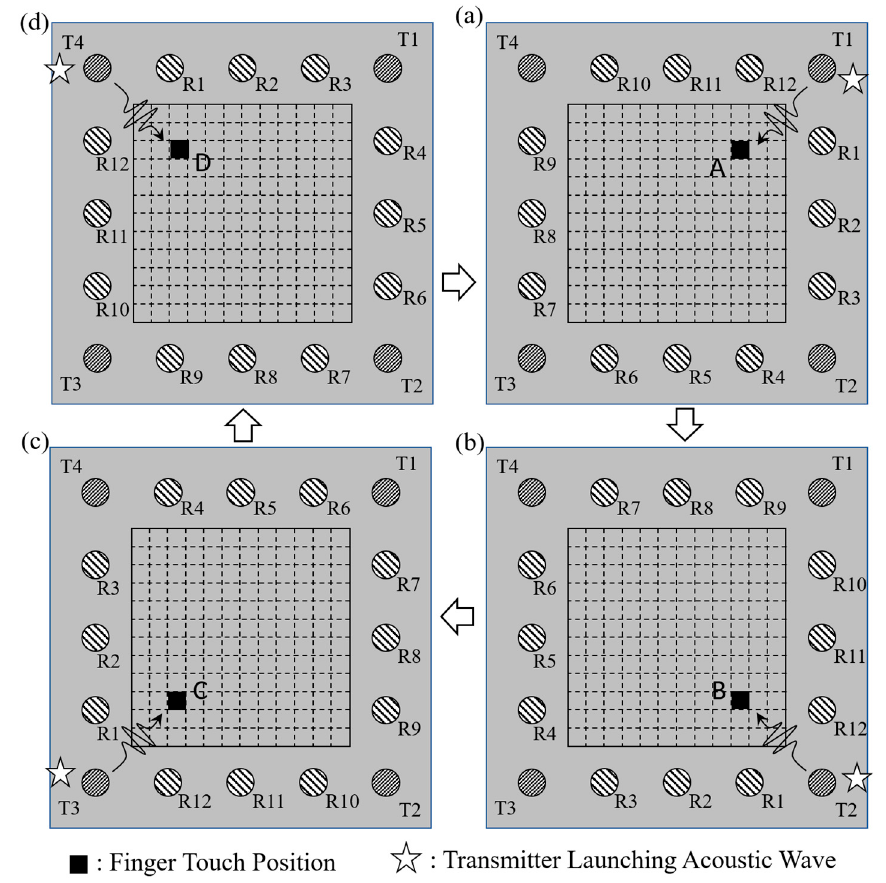
Figure 11. Rotating numbering system for 12 receivers (R1 to R12), based on launching transmitter at ( a ) T1, ( b ) T2, ( c ) T3, and ( d ) T4.